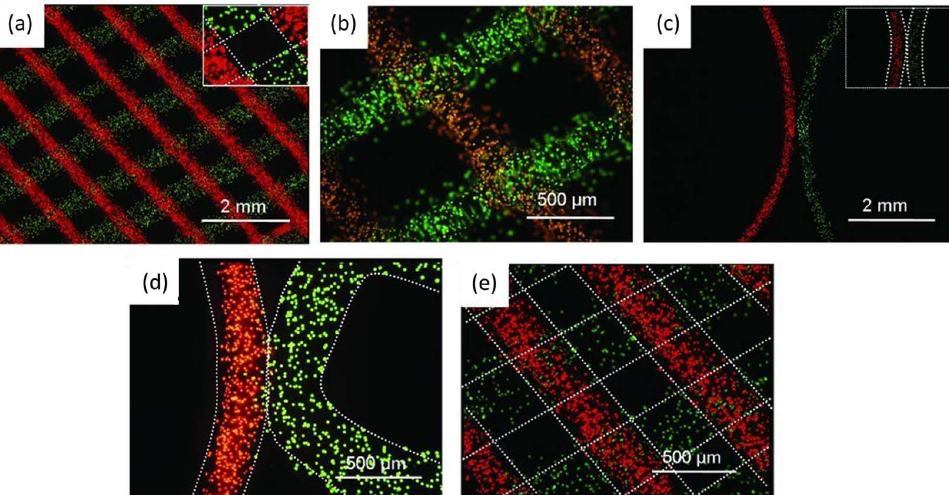
Figure 6. Microscopy pictures of subsequently printed layers of 25 wt% M30P10 hydrogels loaded with Dye-Trak “F” fluorescent microspheres, fluorescent lemon and fluorescent orange, at the con- centration of 1 × 10 6 spheres per mL. ( a ) Two and ( b ) three layer angled constructs (1.5 mm strand spacing) with distinct localization of fluorescent microspheres. ( c , d ) Printing of adjacent fibers with circular patterns with maintenance of distinct dye localization. ( e ) Two layers construct with 0.8 mm strand spacing. Reprinted with permission from